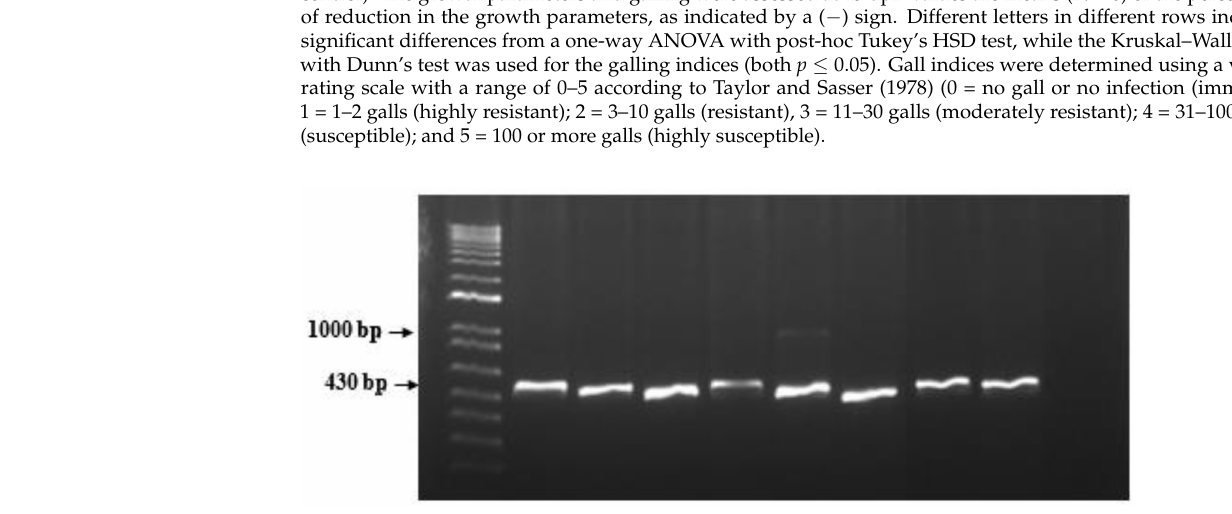
Figure 2. PCR product obtained using the Mi23 marker in different tomato varieties infected with Meloidogyne incognita . From left to right: 1 kb plus DNA ladder, Diamante Max F1, Ilocos Red, Rosanna (susceptible control), Athena, Avatar TY F1, Rica, Tm 2016 11-1 Cherry and 2018-54 Cherry Tm LTB. The amplified band has a fragment size of 430